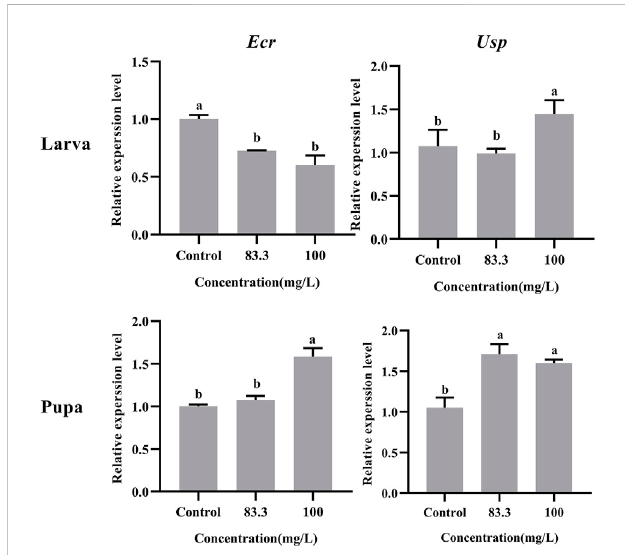
FIGURE 1 Effects of pyraclostrobin on the relative expression of development-related genes ( Ecr and Usp ) in Apis mellifera larva and pupa.Thedata inthe fi gures aremean± SE(standard error)anddifferent